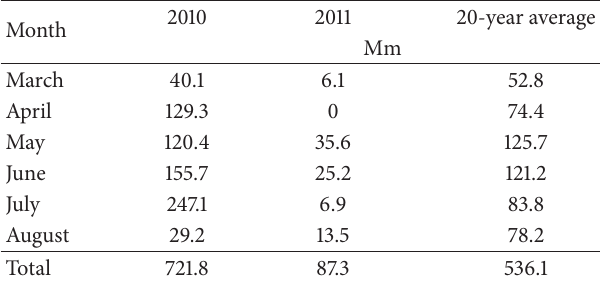
Table 1: Monthly rainfall during the growing season at study loca-